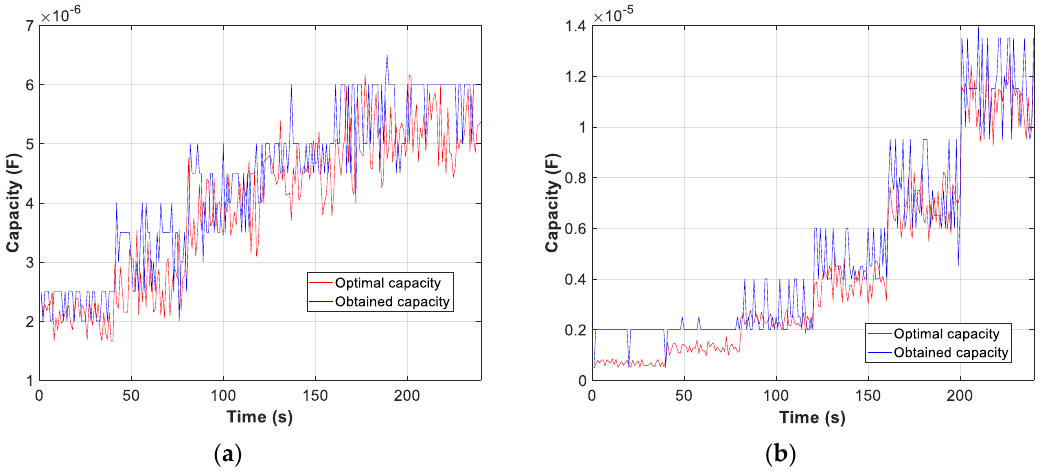
Figure 17. Comparison obtained vs optimal capacity: ( a ) Series connection; ( b ) Parallel connection.